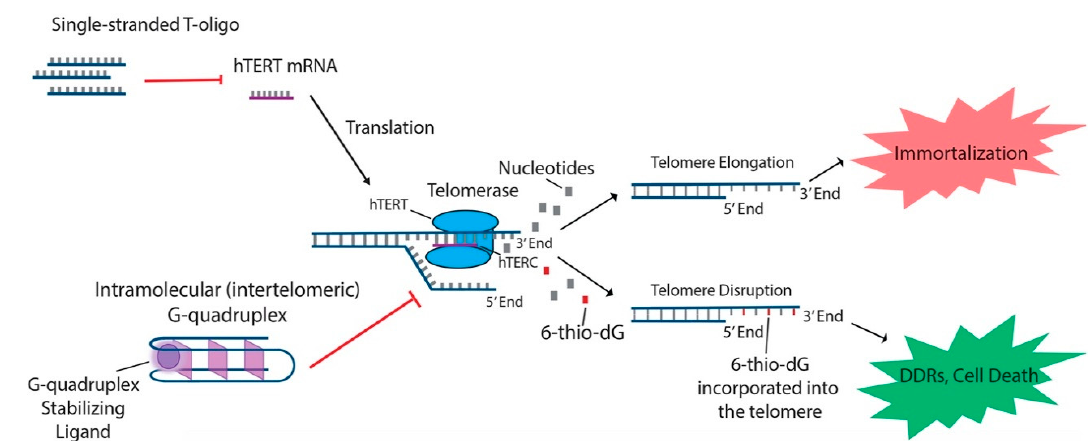
Figure 2. T-oligo, 6-thio-dG, and G-quadruplex stabilizing ligands like telomestatin function to prevent telomere elongation through unique processes related to inhibition of the telomerase subunits. T-oligo has been shown to inhibit expression of hTERT mRNA in melanoma cells with activated JNK signaling. 6-thio-dG incorporates into telomeric DNA and stimulates TIFs in cells that exhibit hTERT activity. G-quadruplex stabilizing ligands prevent hTERC from binding to the single-stranded telomere overhang.